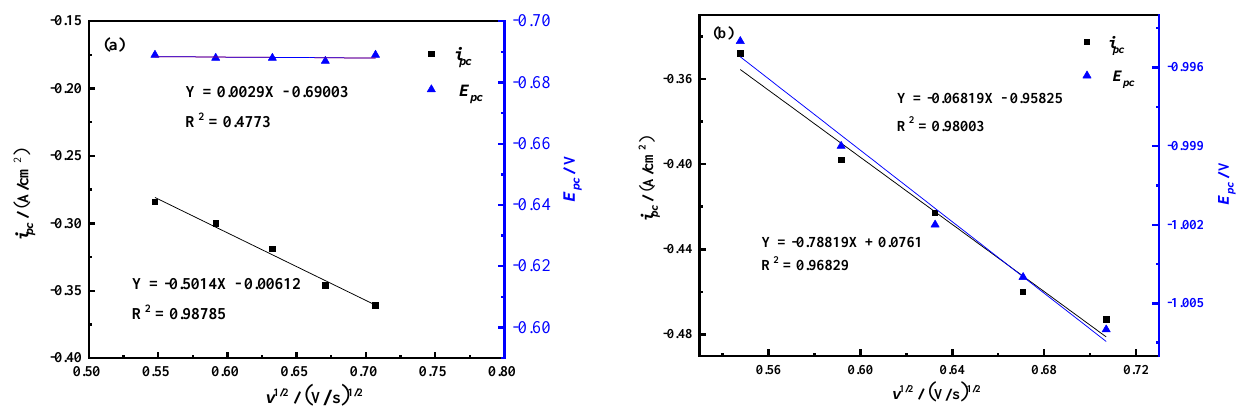
Figure 3. Curves of reduced peaks i pc - v 1/2 and E pc - v 1/2 ( a ) Peak C ( b ) Peak B (A = 0.08046 cm 2 ).